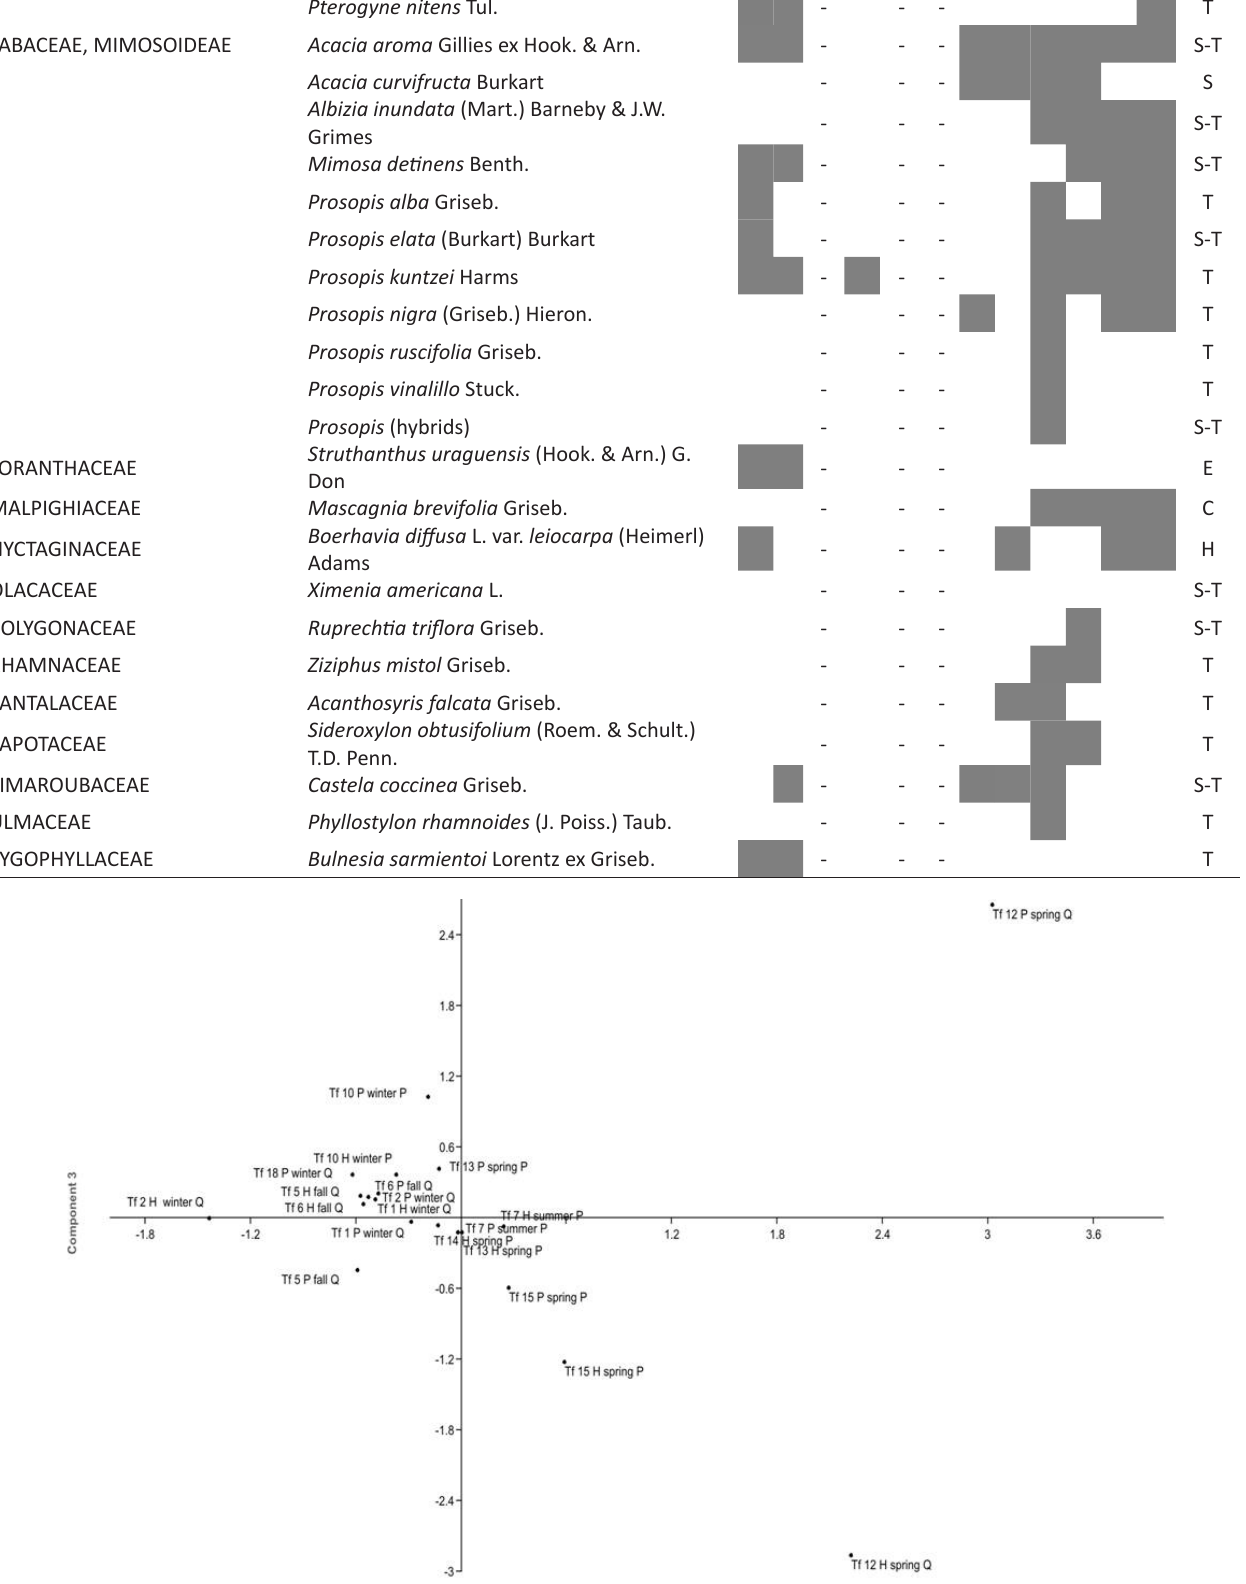
Fig 3 . Two-dimensional graph of the Principal Components 1 and 3 showing the distribution of store